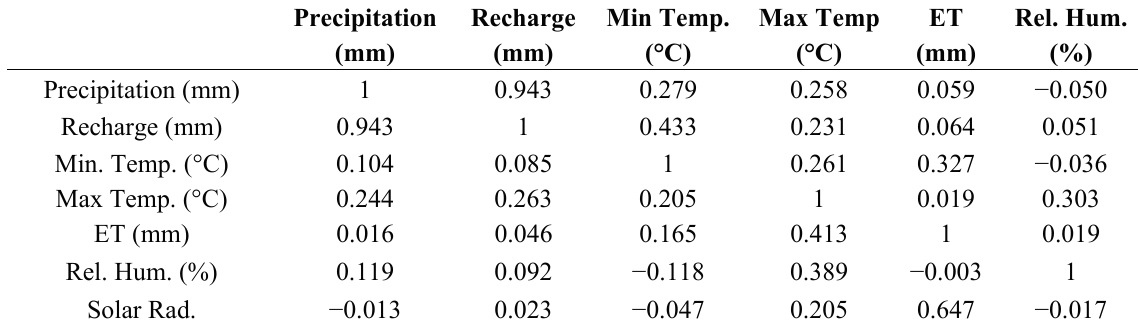
Table 5. Pearson correlation coefficient for meteorological parameters.